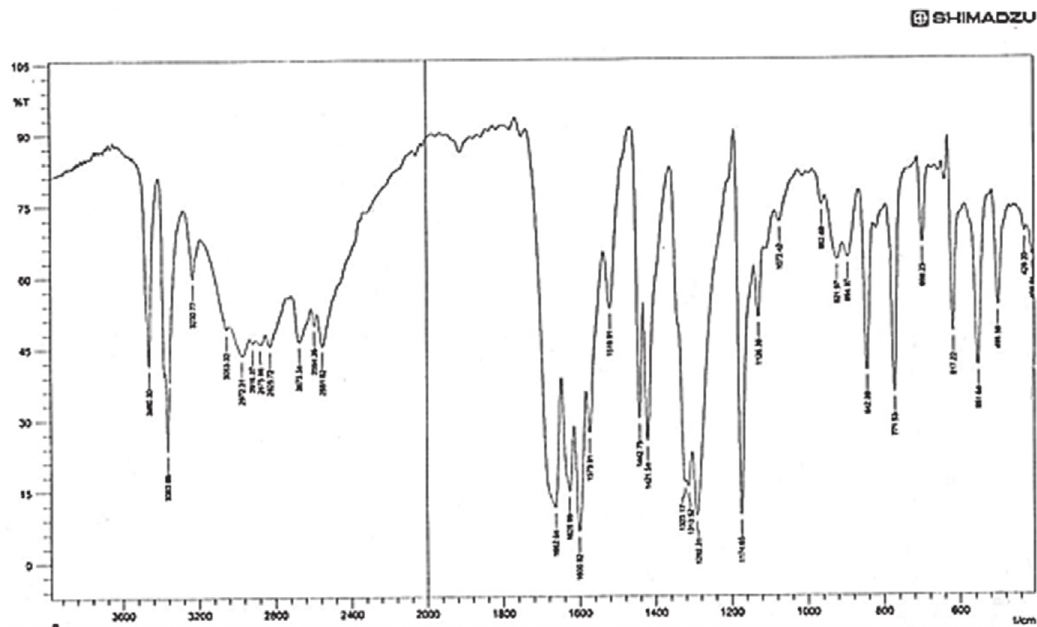
Figure 2: FTIR of